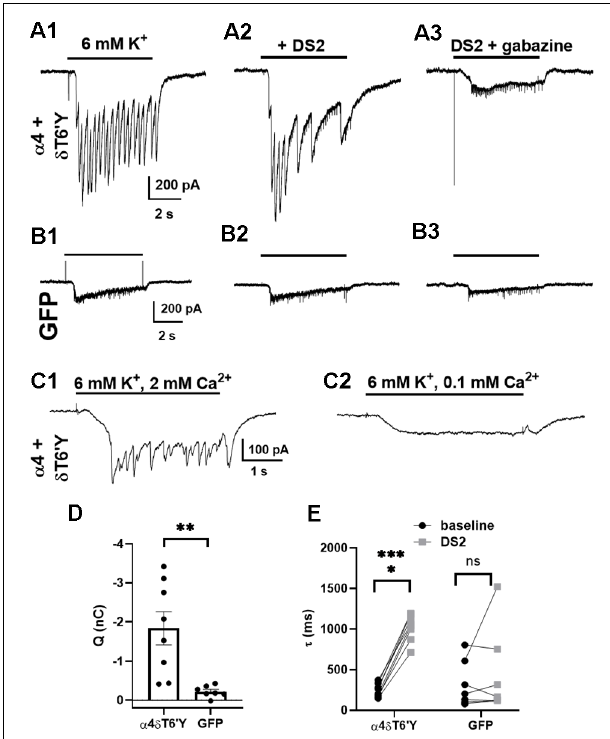
FIGURE 5 | Synaptic activation of transduced δ T6’Y subunits in rat hippocampal cultures. (A1–3) Example traces of IPSCs induced by 6 mM K + depolarizing stimulation after transduction of δ T6’Y subunits along with α 4 subunits (A1) . NBQX and D-APV were used to block AMPAR and NMDAR activation, respectively, and 50 µ M PTX was applied throughout. The K + evoked IPSCs were enhanced by co-application with 1 µ M DS2 (A2) , and sensitive to 10 µ M gabazine (A3) . The frequency of IPSCs may be reduced in (A2) due to enhanced network inhibition with DS2 application. Residual transient inward currents may represent small breakthrough IPSCs or small action currents elicited by K + depolarization in poorly clamped dendrites. (B1–3) The same protocol was applied to neurons transfected with GFP alone. The current initiated by 6 mM K + was smaller, and DS2 enhancement was absent. (C1,2) In the presence of PTX, NBQX, and D-APV, phasic events in a δ T6’Y + WT α 4 transduced neuron were blocked by reduced Ca 2+ ( n = 10/10 cells), consistent with the synaptic release of GABA driving postsynaptic responses. Upon reduction of extracellular Ca 2+ to 0.1 mM in panel (C2) , extracellular Mg 2+ concentration was increased to 3 mM to preserve total divalent cation concentration. (D) Quantification of PTX-insensitive synaptic charge for δ T6’Y and control transfections ( n = 8, 7, unpaired t-test with Welch’s correction, p = 0.006). The charge was integrated over the duration of K + application, and charge in the presence of GBZ was subtracted for the plots. (E) Summary of decay time constant τ (ms) of the final IPSC of the barrage caused by K + application. DS2 significantly prolonged the decay of synaptic currents, indicating δ contribution to the α 4 + δ T6’Y group but not the GFP control cells ( n = 8, 7; 2-way ANOVA with Sidak’s multiple comparison test P < 0.0001 for α 4 + δ T6’Y). The additional variability in (D) for the GFP control data likely arises from the fits to small-amplitude currents [e.g., (B1) and (B2) vs. (A1) and (A2) ]. ∗ p < 0.05, ∗∗ p < 0.01, ∗∗∗ p < 0.001, ns = not